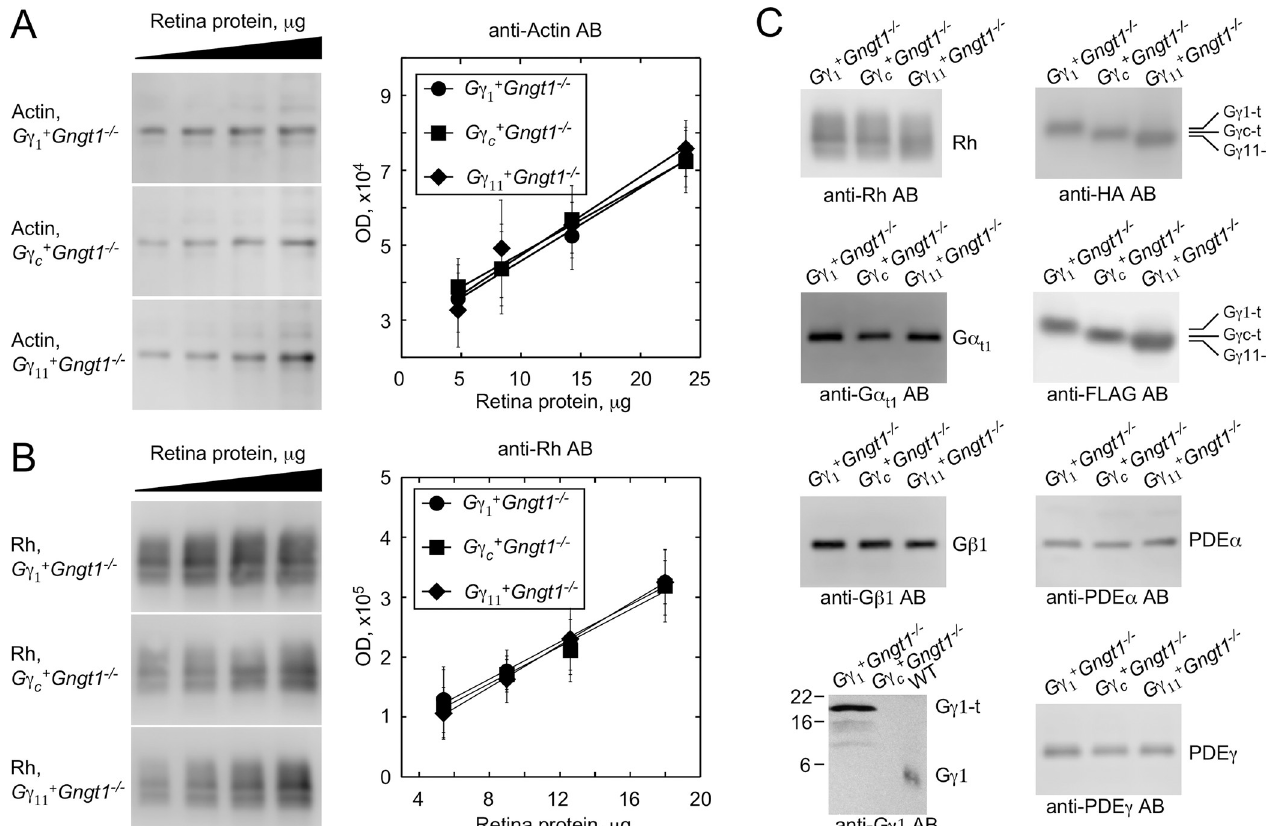
Fig 4. Western blot analysis of retina homogenates obtained from indicated transgenic mice. Representative staining for actin ( A ) and rhodopsin ( B ) in samples with progressively increasing amounts of loaded retina homogenate obtained from G γ optical density of Western blot bands against amount of total retina protein (n = 3). Linearity of plots demonstrates sub-saturating ECL signal ensuring direct quantitative comparison. ( C ) Comparative staining of samples from the G γ 1+ Gngt1 -/- , G γ c+ Gngt1 -/- , and G γ 11+ Gngt1 -/- retina homogenates using indicated antibodies against rhodopsin, G α t1 , G β 1, G γ 1, HA, FLAG, PDE α , and PDE γ subunits.